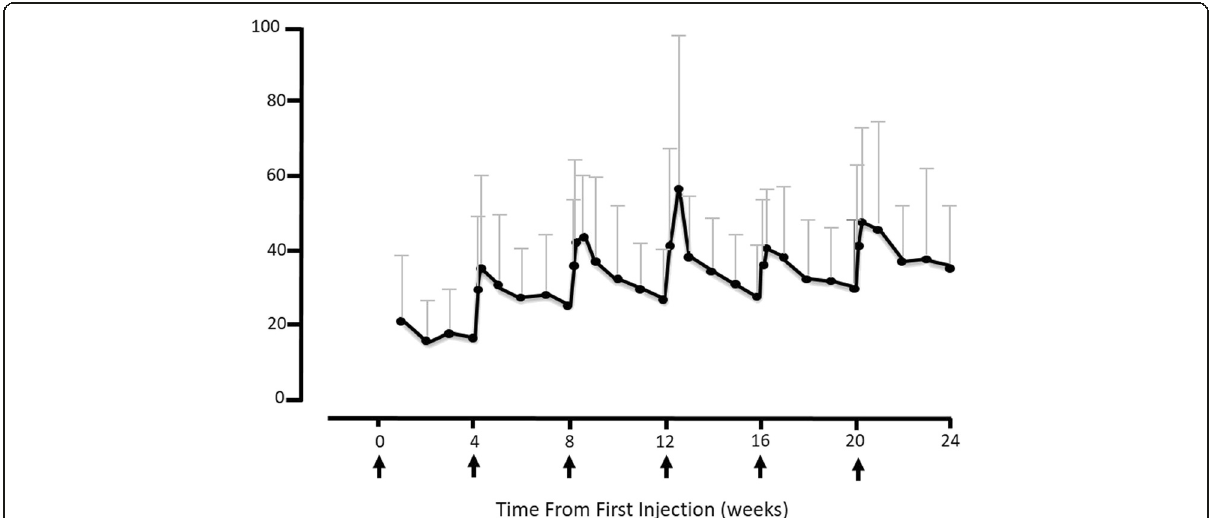
Fig. 13 Mean olanzapine plasma concentrations for the Multiple-Dose Group receiving 405 mg/4 weeks; arrows along x-axis indicate injections (adapted from reference (Agency et al. 2015))